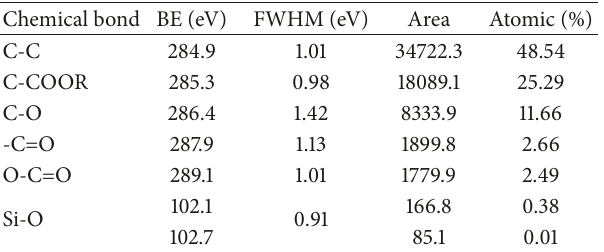
Table 2: Chemical statuses of C and Si atoms in EF PE analyzed with XPS.